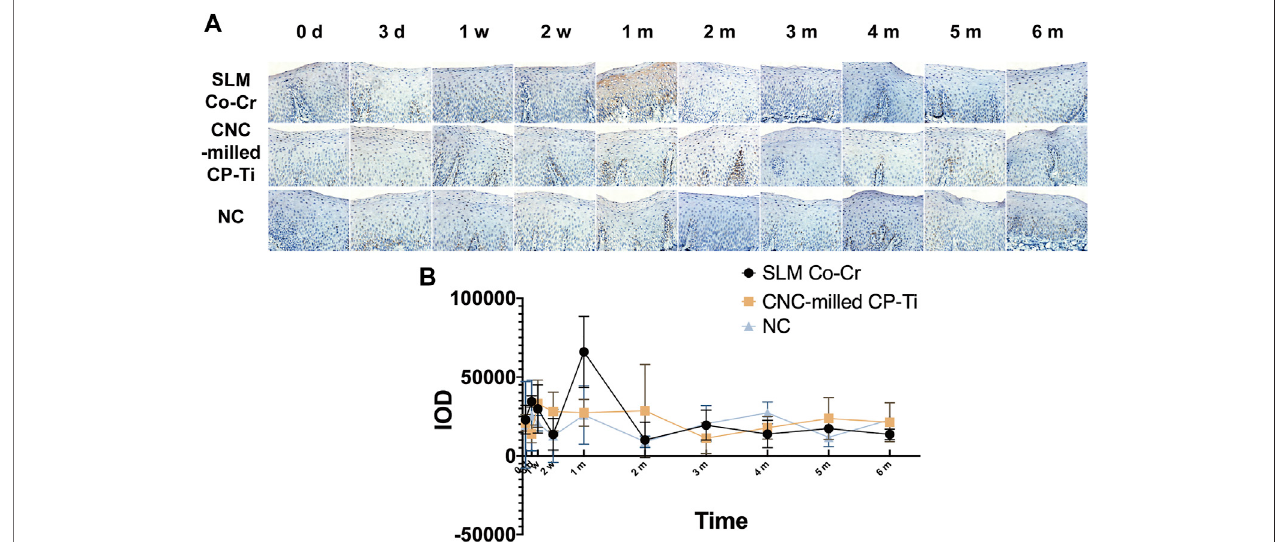
FIGURE 5 | Representative images and quanti fi cation of cleaved Caspase-3 protein expression in the oral mucosa affected by SLM Co-Cr alloys and CNC-milled CP-Ti. Panels show (A) theexpression ofcleaved Caspase three protein with brownstaining, (B) levels ofcleaved Caspase-3 protein expression were evaluated byIOD using Image-Pro Plus software (original magni fi cation 400 × ). The expression of cleaved Caspase-3 protein in the SLM Co-Cr alloy group peaked only at the 1-month time point but remained relatively steady at other time points, while that in the CNC-milled CP-Ti group was stable.